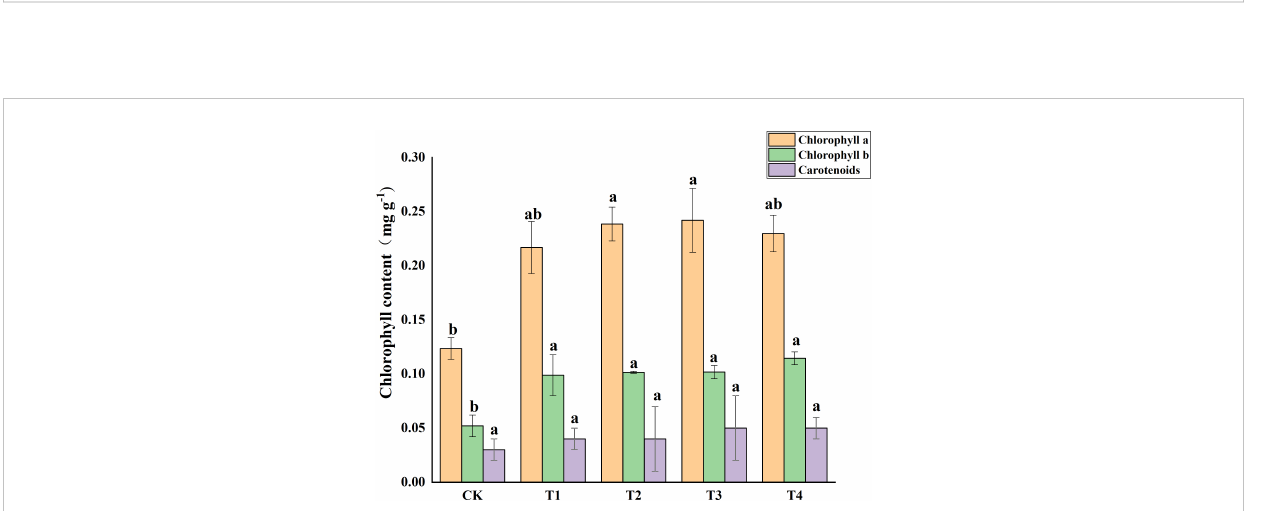
FIGURE 4 Effects of different Si treatments on chlorophyll content of S. alfredii . CK: control treatment, T1, T2, T3 and T4 were the Si concentrations of 0.5, 1.0, 1.5 and 2.0 mmol ∙ L -1 , respectively. Values are mean ± SD and columns denoted with different letters indicate signi fi cant differences between treatments at P < 0.05.